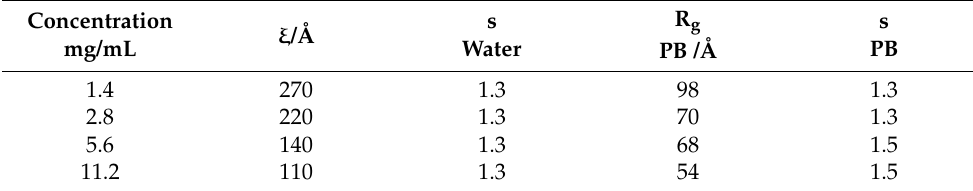
Table 3. HYA in solution. Characteristic exponents in water and PB, inter-chain characteristic distance ξ , mean gyration radius R g